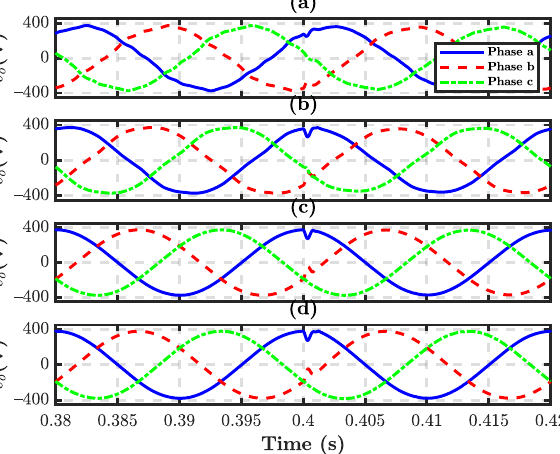
Figure 25. MG three-phase voltages under nonlinear load changes with different designed parameters: ( a ) conv.; ( b ) GA; ( c ) PSO; ( d )